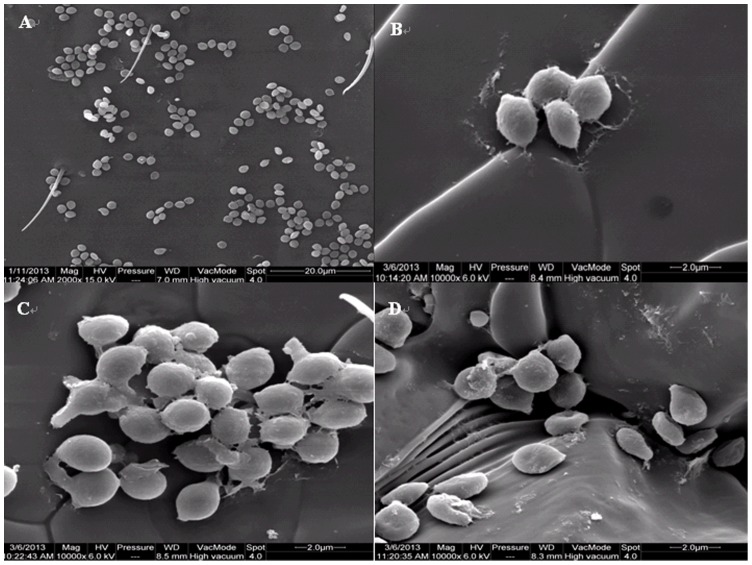
Inoculation and attachment of B. bassiana strain SZ-26 conidia on the cuticle of N. barkeri.(A) conidia adhering to the cuticle of N. barkeri; (B) secretion on the interface of conidia and cuticle; (C) germ tube of conidia oriented toward cuticle; (D) shriveled condia